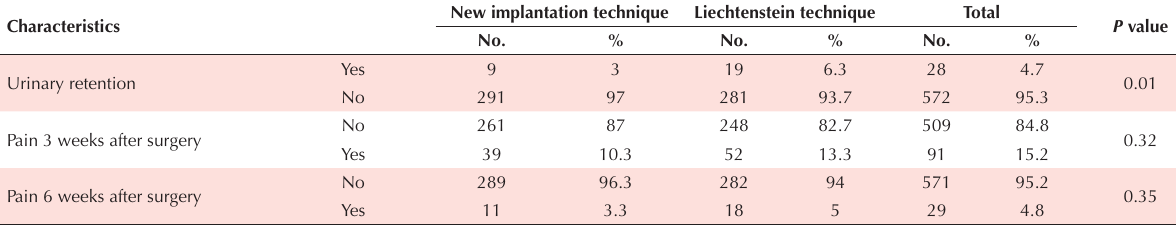
New implantation technique